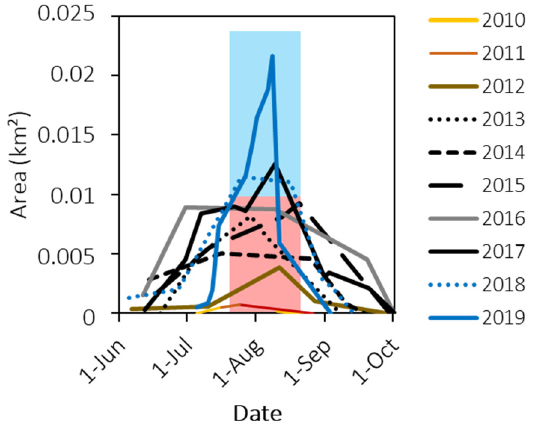
Figure 5. Toguz-Bulak lake area during 2010–2019. Red shading shows small seasonal